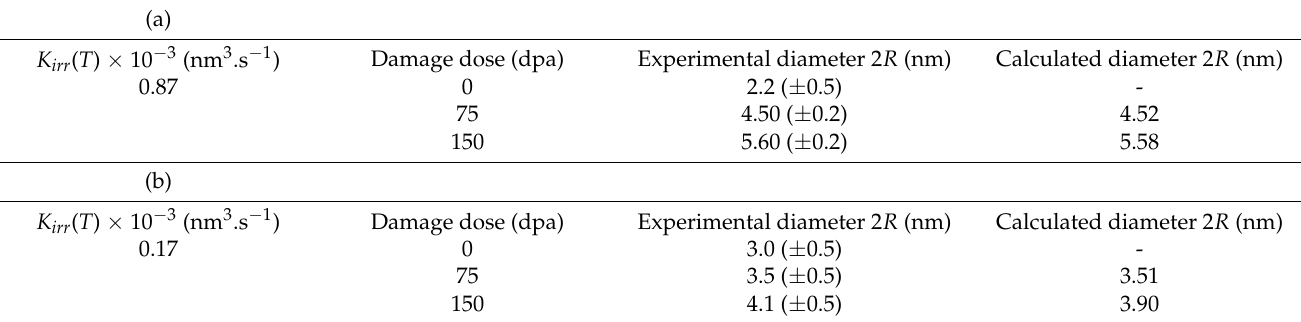
Table 7. Comparison between experimental and calculated nano-oxide diameter after radiation-enhanced Ostwald ripening in (a) Fe-14Cr ODS steel and (b) Fe-18Cr ODS steel.